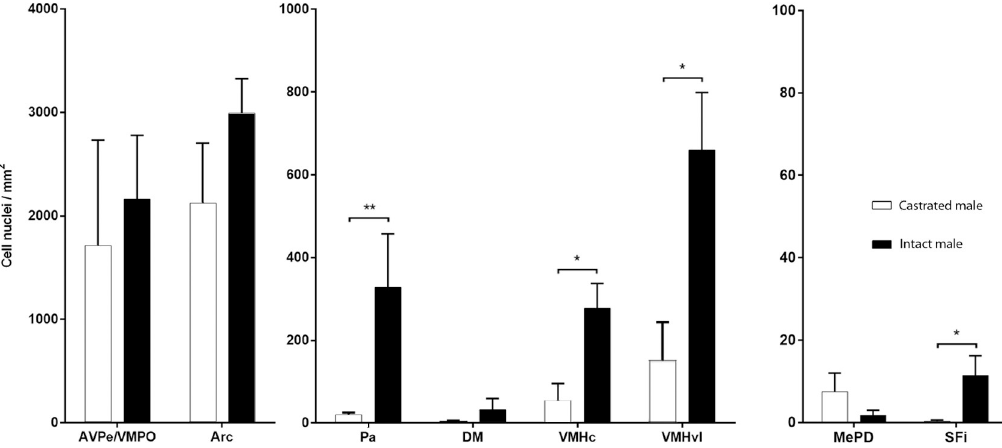
Fig 4. Effect of testosterone withdrawal in pSTAT5 immunoreactivity of the male mouse brain. Assessment of pSTAT5-ir density (pSTAT5-positive cell nuclei/mm 2 ) in gonadally-intact male mice and castrated male mice within the major brain regions showing pSTAT5 expression in the male mouse brain. Bar histograms show mean interhemispheric pSTAT5-ir density ± SEM in intact, PRL-supplemented males (Males+PRL; n = 6; black) and castrated, PRL-supplemented males (Castrated+PRL; n = 6; white). Counting frames for each of the analyzed nuclei are enclosed in Fig 2. Statistical analysis was applied independently to each brain region (independent t-test for parametric data or Mann-Whitney test for non-parametric data). � P � 0.05; �� P �